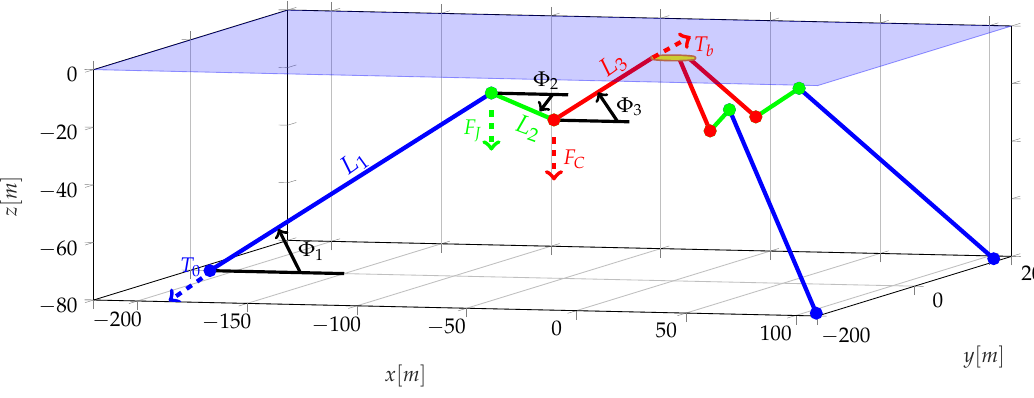
Figure 3. Mooring system layout with three lines 120 ◦ apart. Each line is divided in three segments of length L 1 , L 2 , and L 3 . F C is the net clump-weight force and F J is the net jumper force (negative in the figure). The quasi-static model solves for the tension at the vessel ( T v ), the tension at the anchor ( T 0 ), and the angles of the three lines ( Φ 1 , Φ 1 , and Φ 3 ). Table 3. Parameters of the full-scale mooring system, based on the experimental tests in [32].